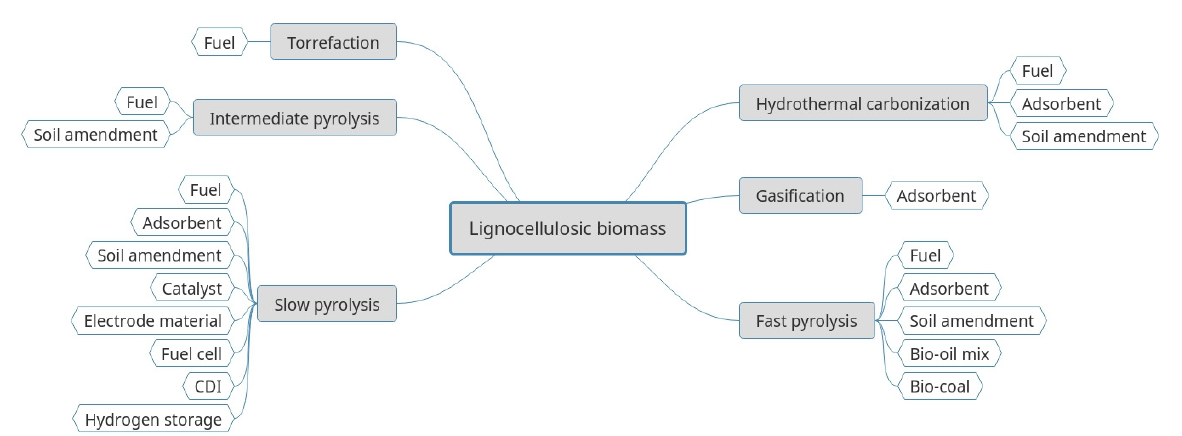
Figure 1. An overview of thermochemical treatments of biomass and of the applications of the resulting chars. Capacitive deionization, (CDI).